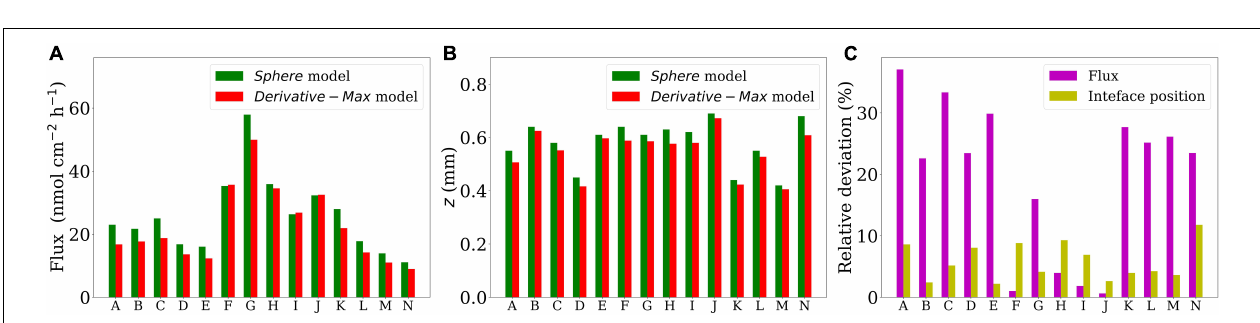
FIGURE 3 | Head-to-head comparison of the fluxes (A) and the interface positions (B) obtained by using the Sphere and Derivative-Max models applied on all the 14 profiles shown in Figure 2 . Panel (C) shows the corresponding relative deviations with respect to the results of Derivative-Max model for each profile.